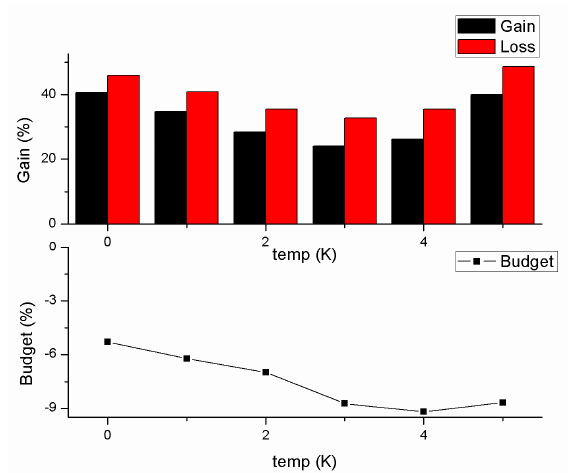
Figure 9. The dynamics of inland water according to the temperatures (the horizontal axis represents the yearly average temperature difference. The x -axis represents the daytime land surface temperature difference. The temperature difference is calculated with the mean temperature for the 16-year period, subtracting the mean temperature in 2000. The unit for the horizontal axis is Kelvin (K)).